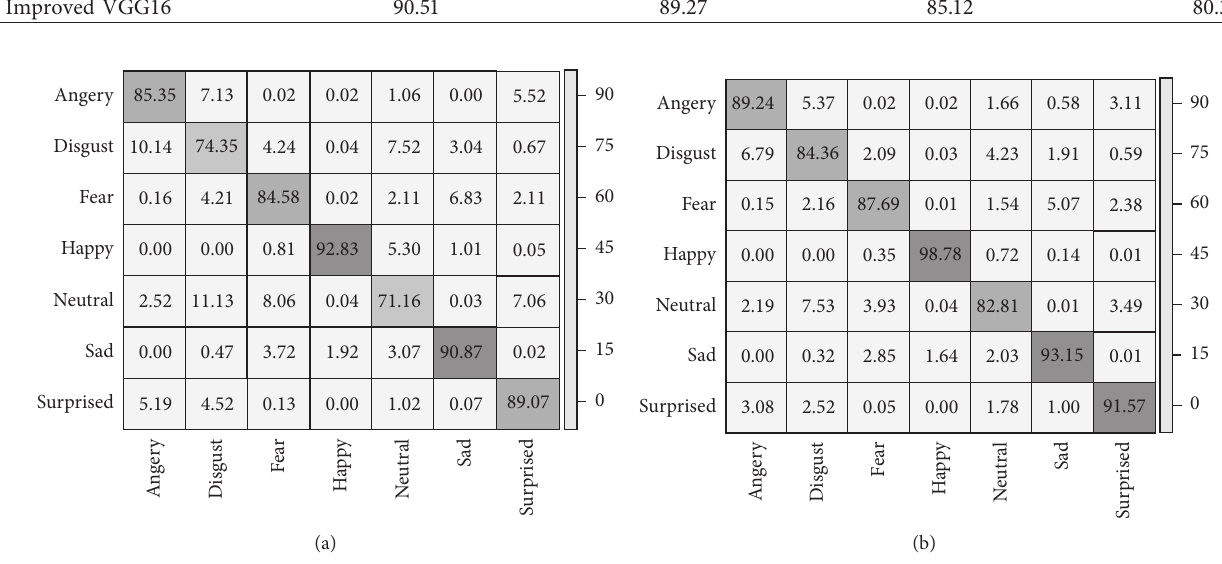
Figure 7: Confusion matrix of expression recognition results of different networks. (a) The VGG16 network. (b) The improved VGG16 network.